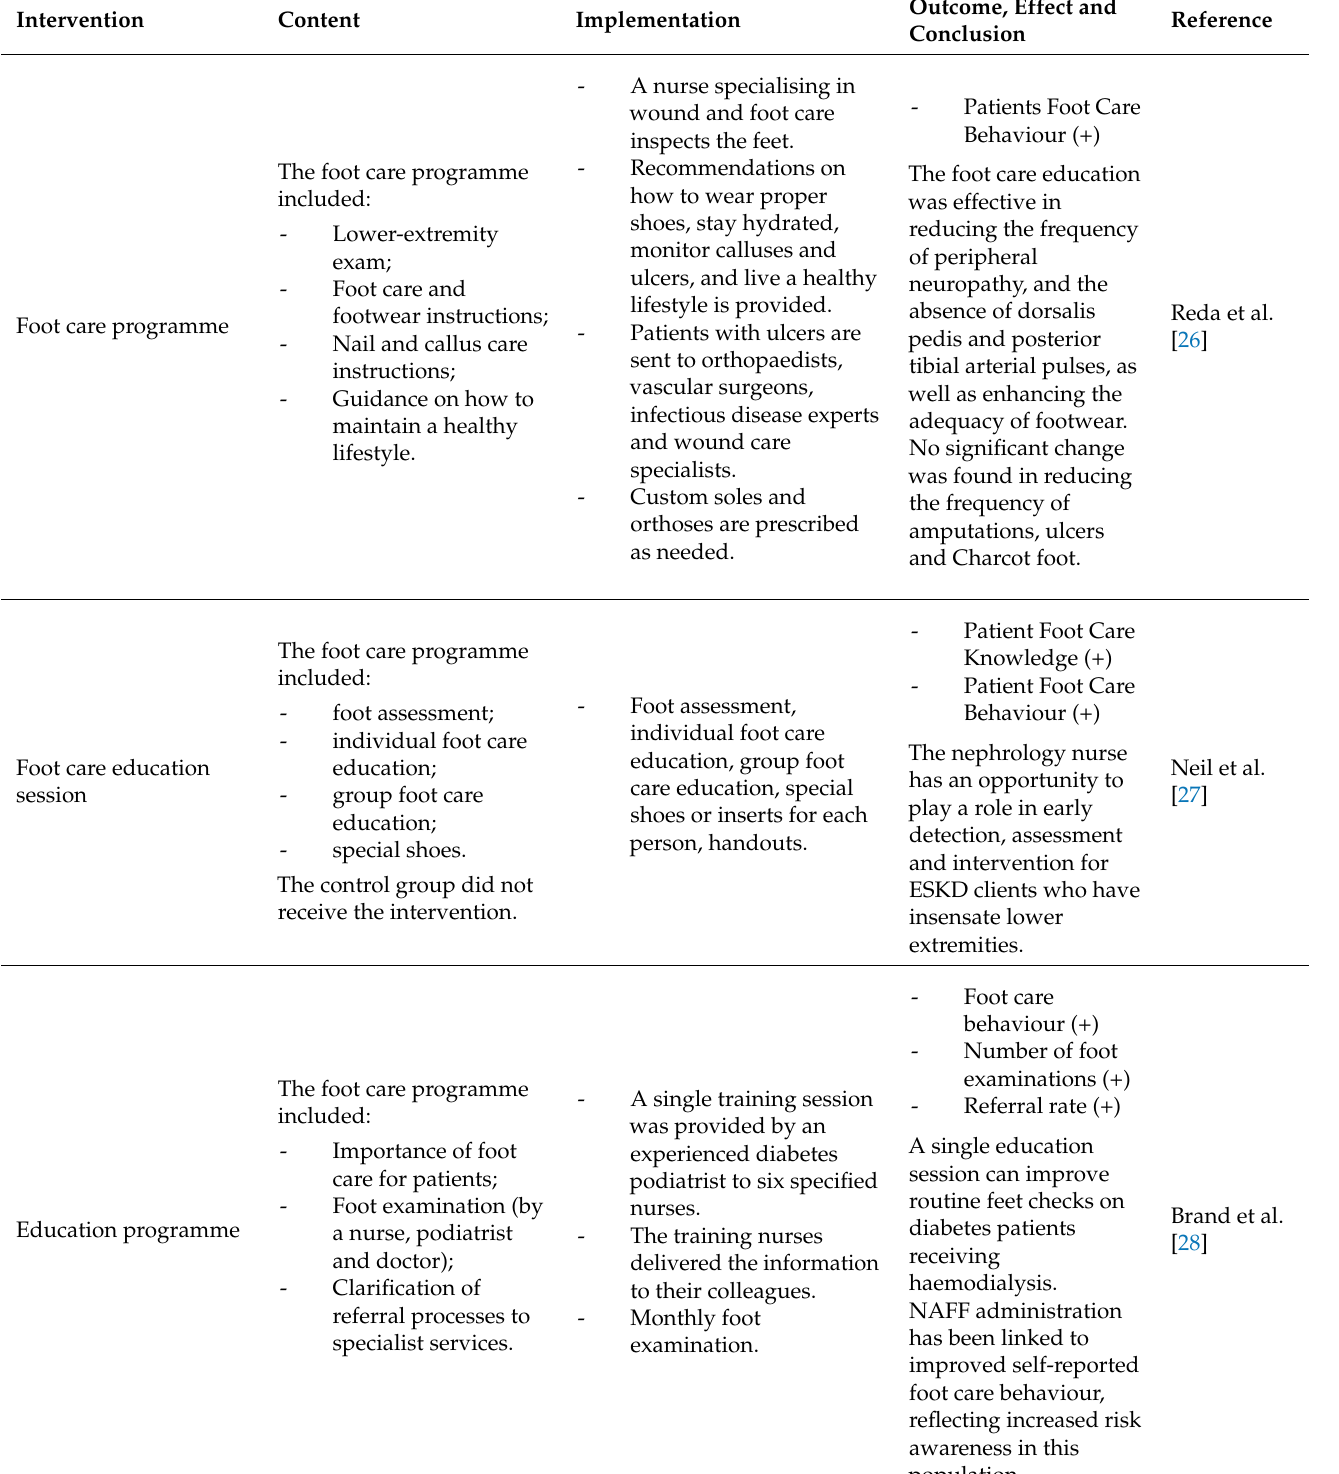
Table 4. Intervention, Content, Implementation and